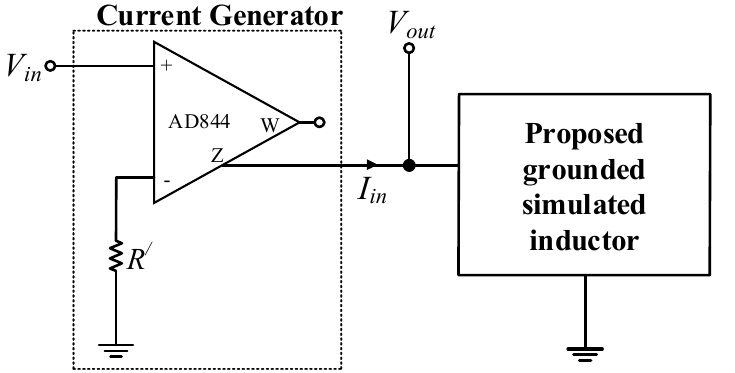
Figure 18. Experimental setup for realizing the grounded simulated inductor.